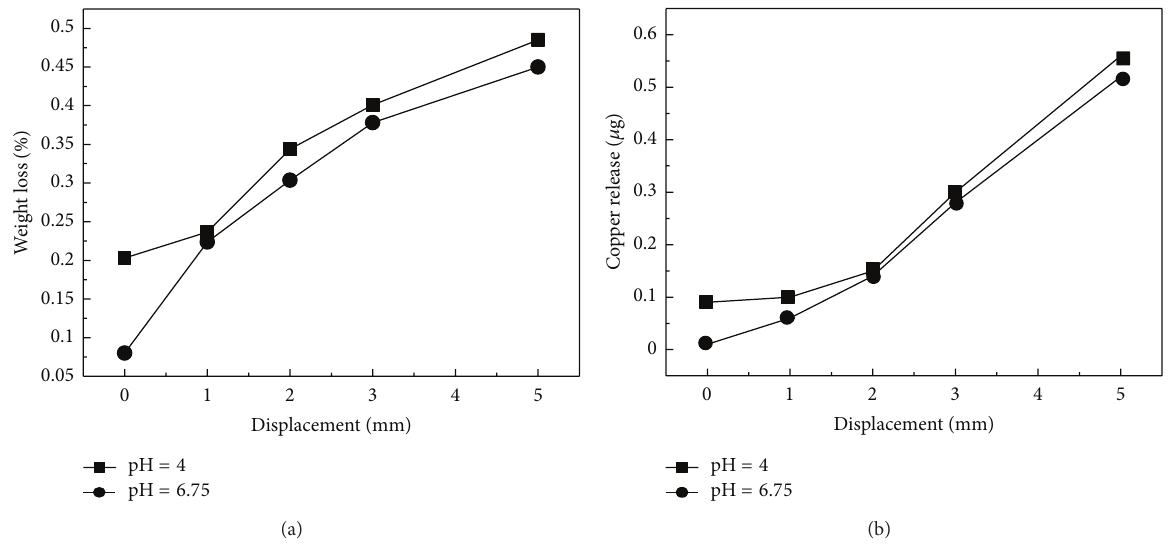
Figure 7: (a) Weight loss and (b) copper release of the composite arch wires in artificial saliva with different pH values.